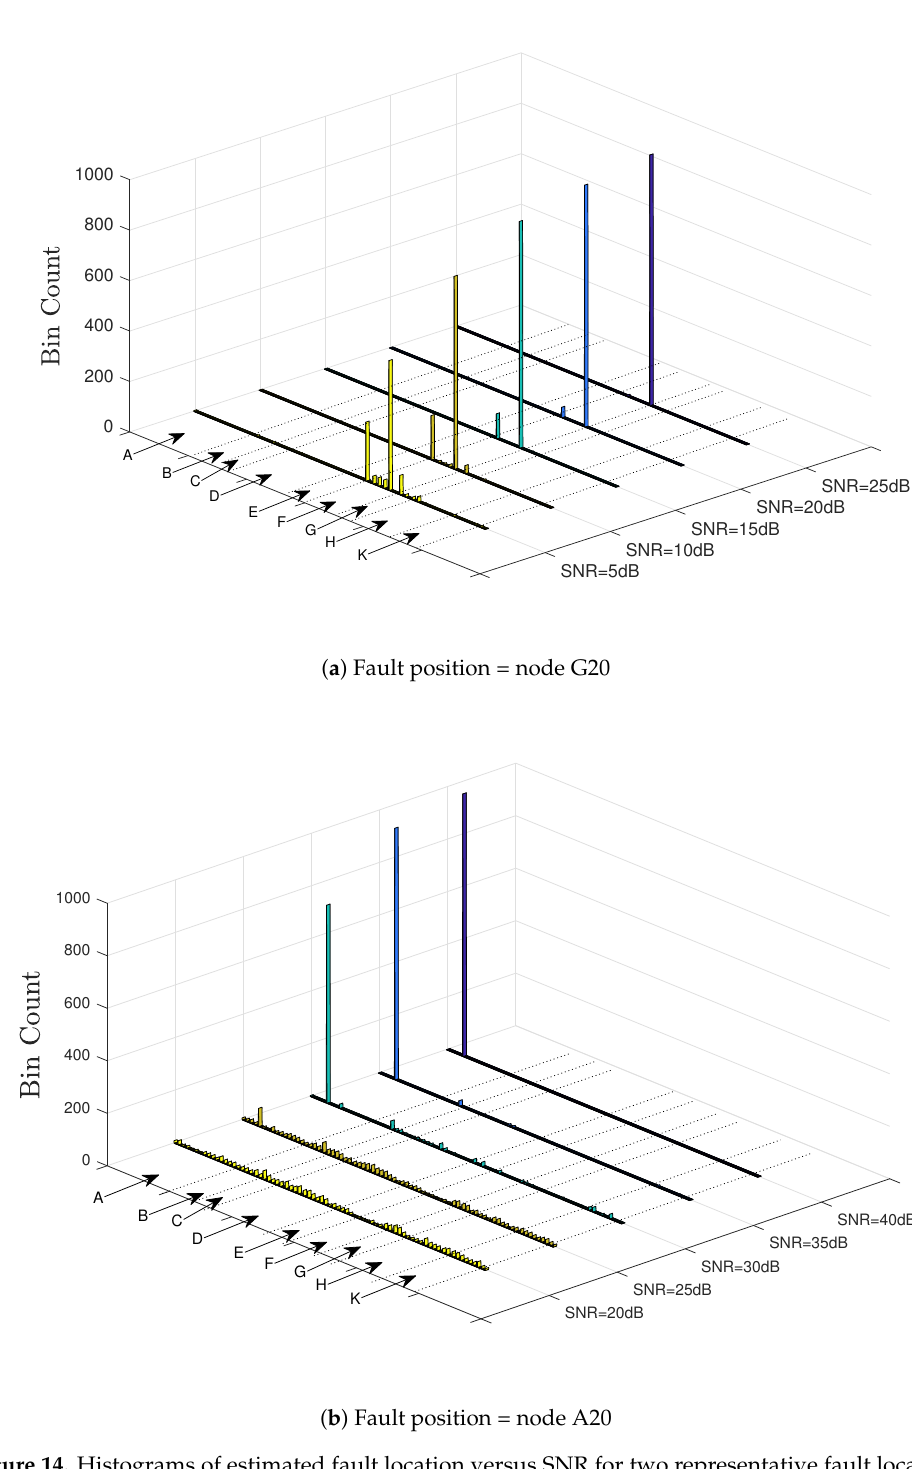
Figure 14. Histograms of estimated fault location versus SNR for two representative fault locations. Each case was run 1000 times at each SNR level. Please note that the two subfigures have different SNR